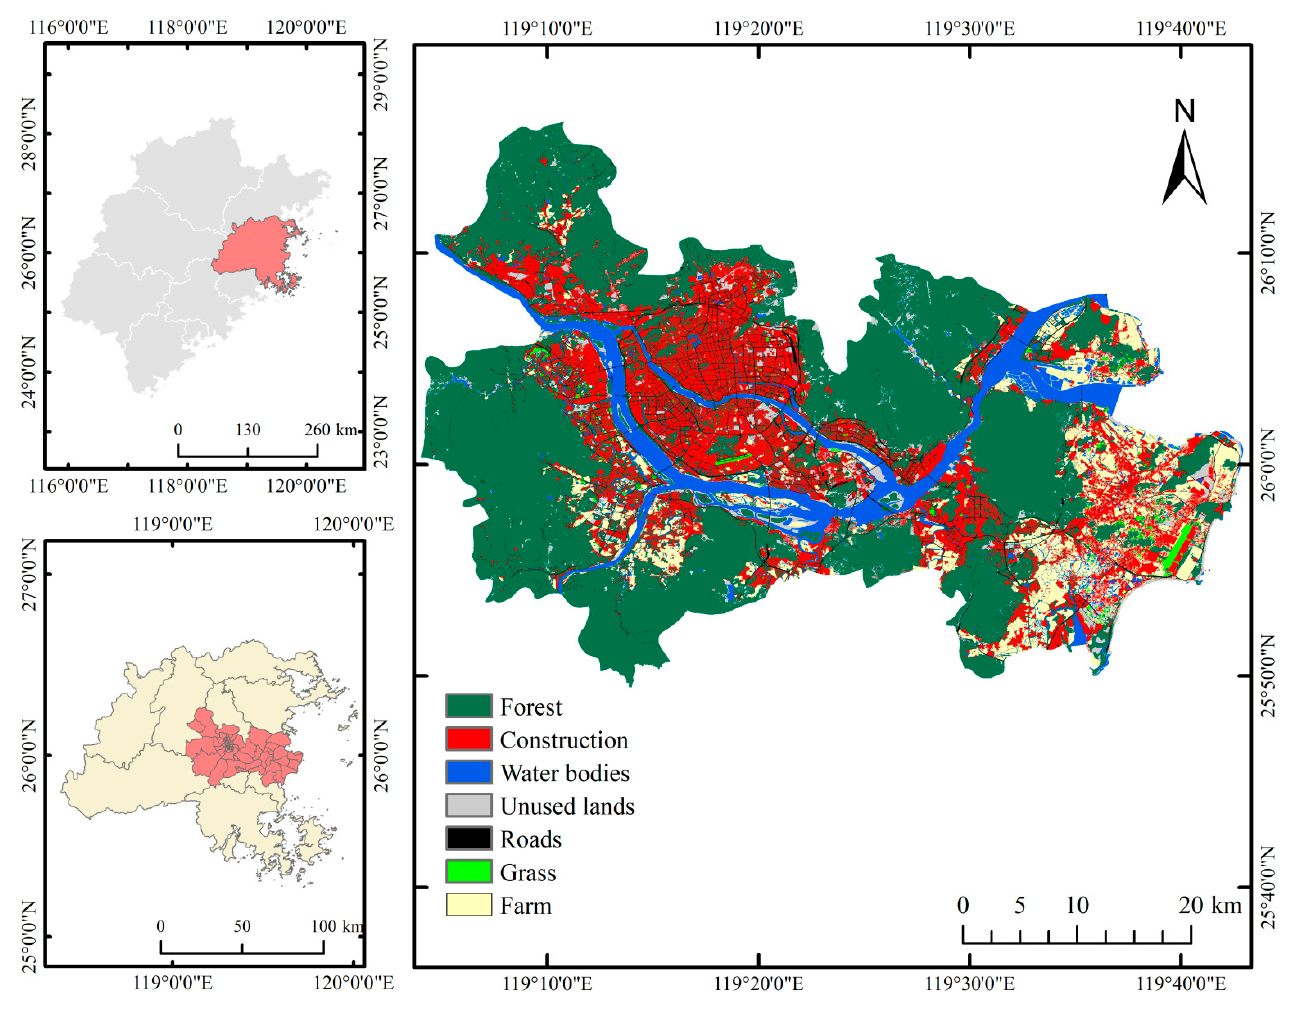
Figure 1. Study area.